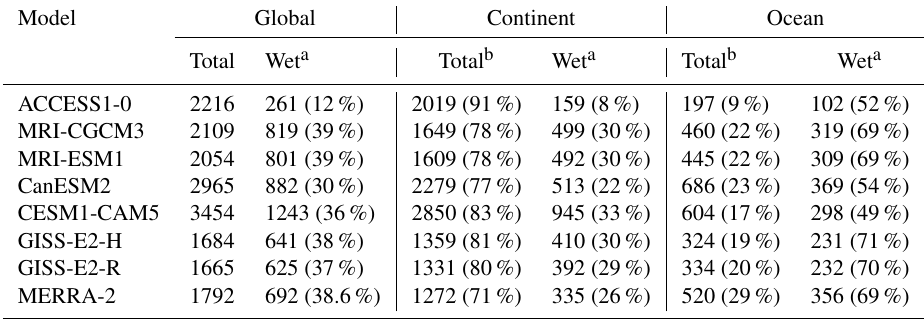
Table 5. Total dust deposition and wet deposition (Tg) in the global surface, continents, and oceans from CMIP5 models and the MERRA-2 reanalysis. Only the seven CMIP5 models with both dry and wet depositions provided are used here. Model Global Continent